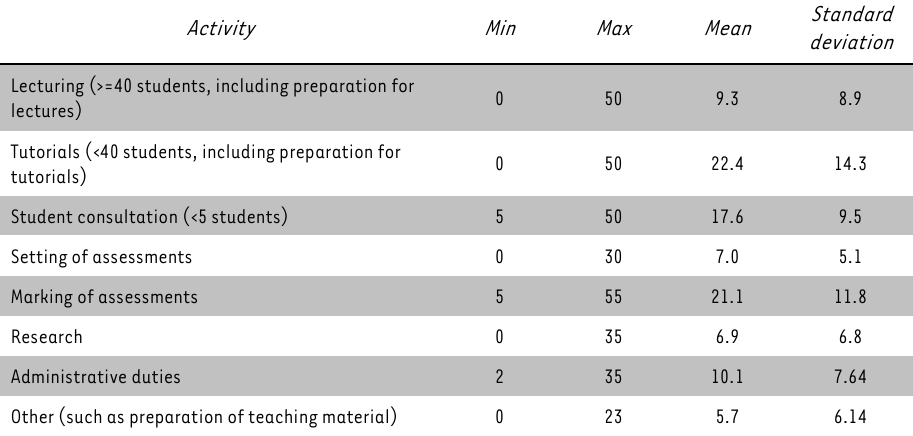
TABLE 3: Actual time spent on academic activities (percentage of total time)